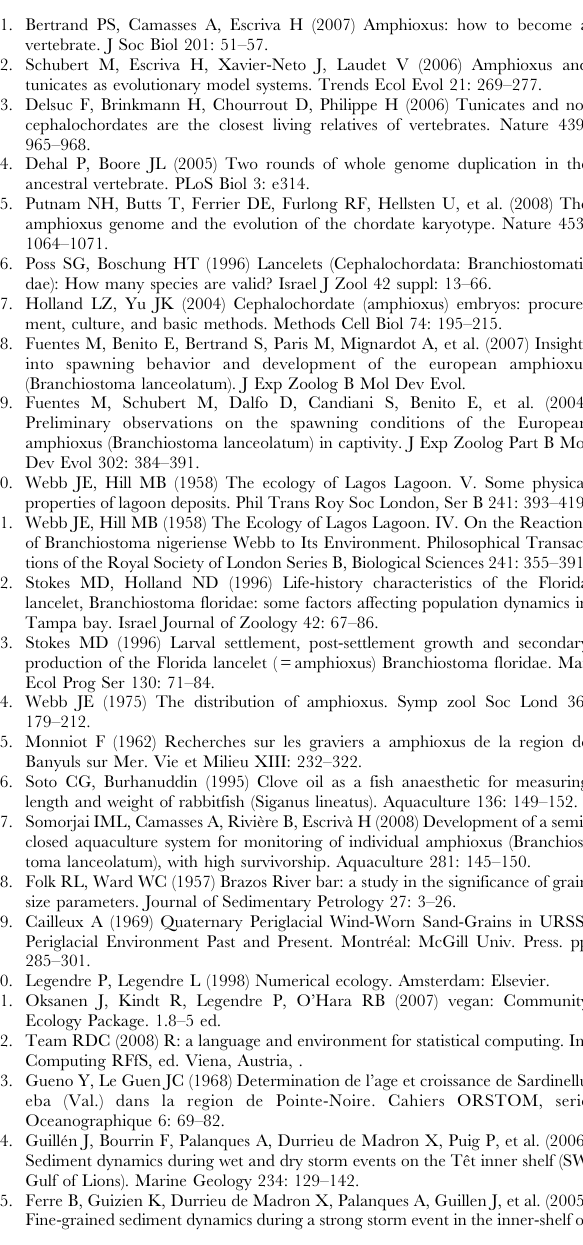
Table S1 Data obtained from the different sites where amphioxus have been found. Sites containing only silt, where amphioxus were absent, have not been included. The total number of animals per site, both juveniles and adults, is indicated as well as their density (both as number of animals/m2 and number of animals/l) and average size. Numbers of adults ( . 3 cm long) and juveniles ( , 3 cm long) are also included. The percentage of silt, sand and gravel in each site is indicated as well as the depth and the collection date. ND: not